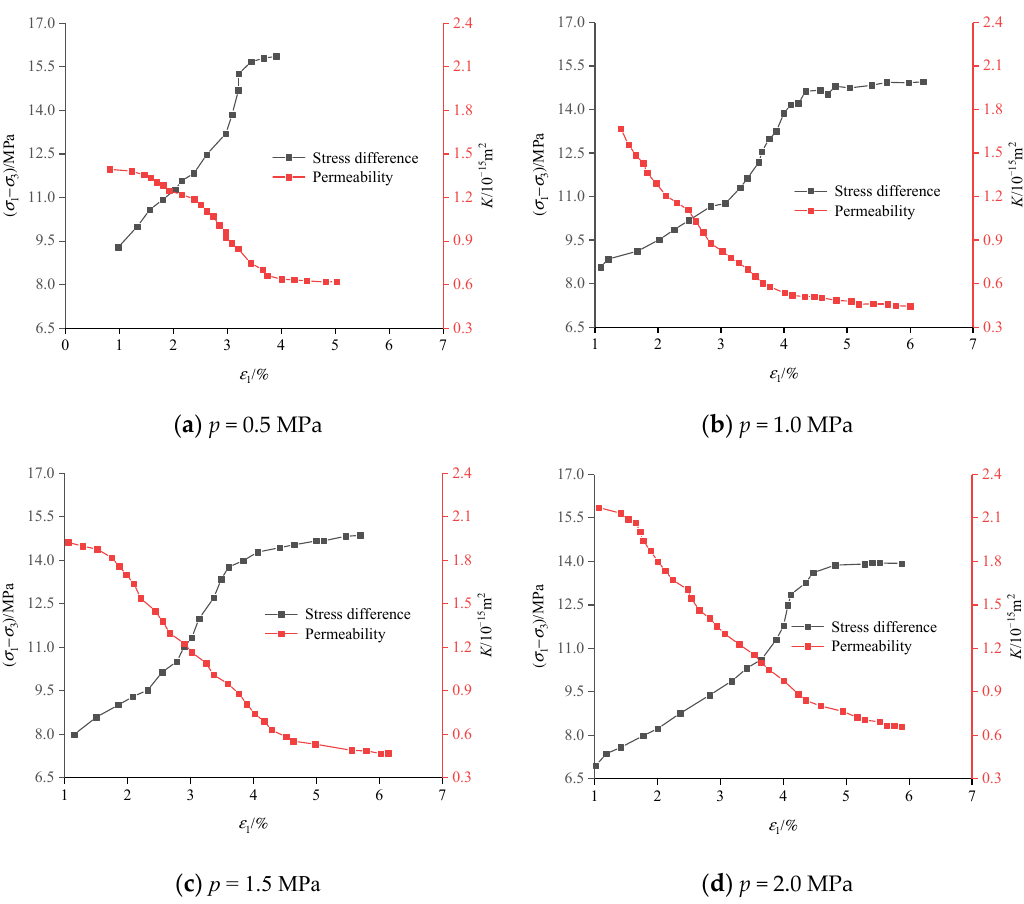
Figure 9. Curves of stress and permeability variations with axial strains of axially unloaded coal samples under a constant CP of 4 MPa and different GPs: ( a ) p = 0.5 MPa; ( b ) p = 1.0 MPa; ( c ) p = 1.5 MPa ; ( d ) p = 2.0 MPa.